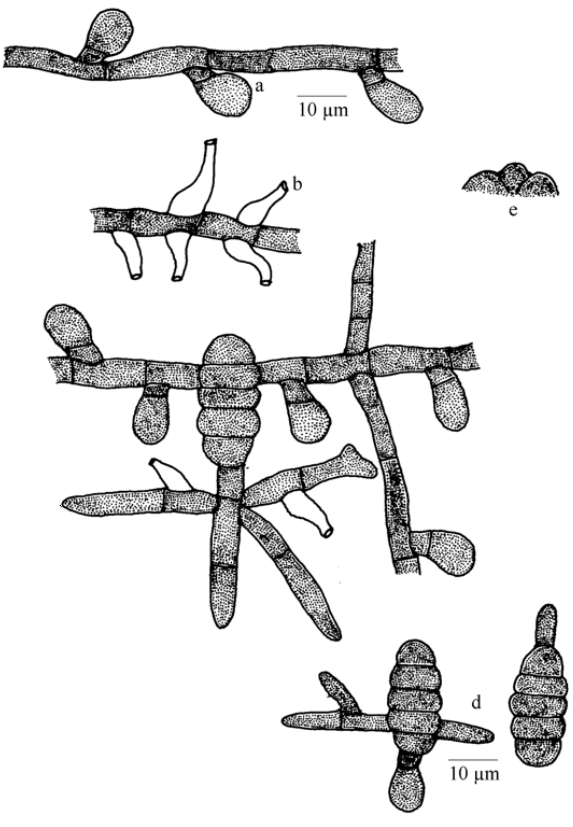
Figure 15. Asteridiella combreti var. leonensis a - Appressorium; b - Phialide; d - Ascospores; e - Perithecial wall